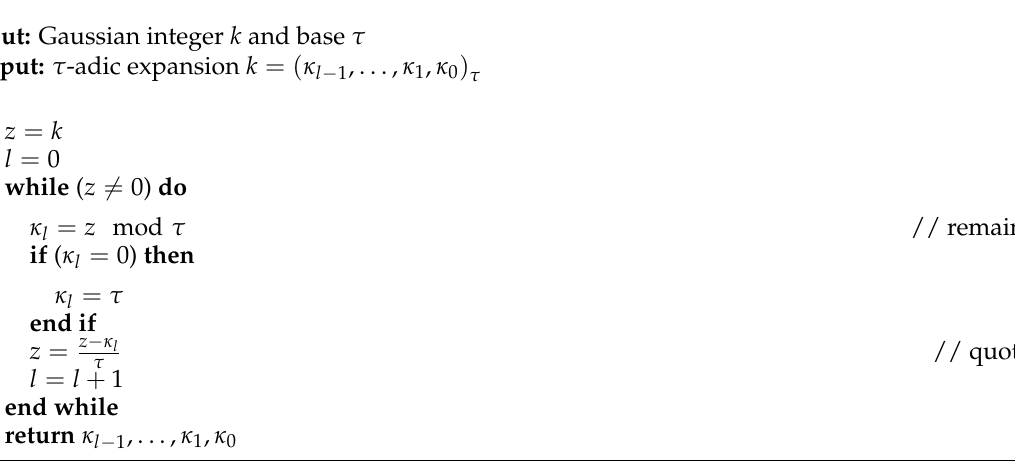
Algorithm 4 SPA resistance τ -adic expansion of a Gaussian integers (or an integer) k according to